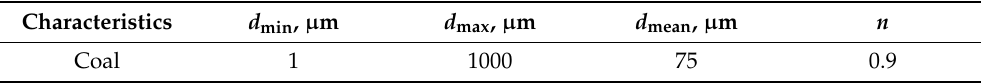
Table 4. Grindability index of